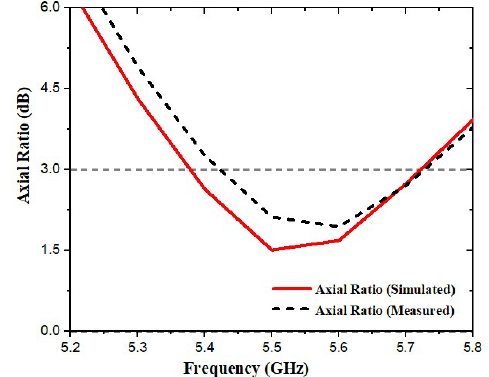
Figure 12. Simulated and measured AR.